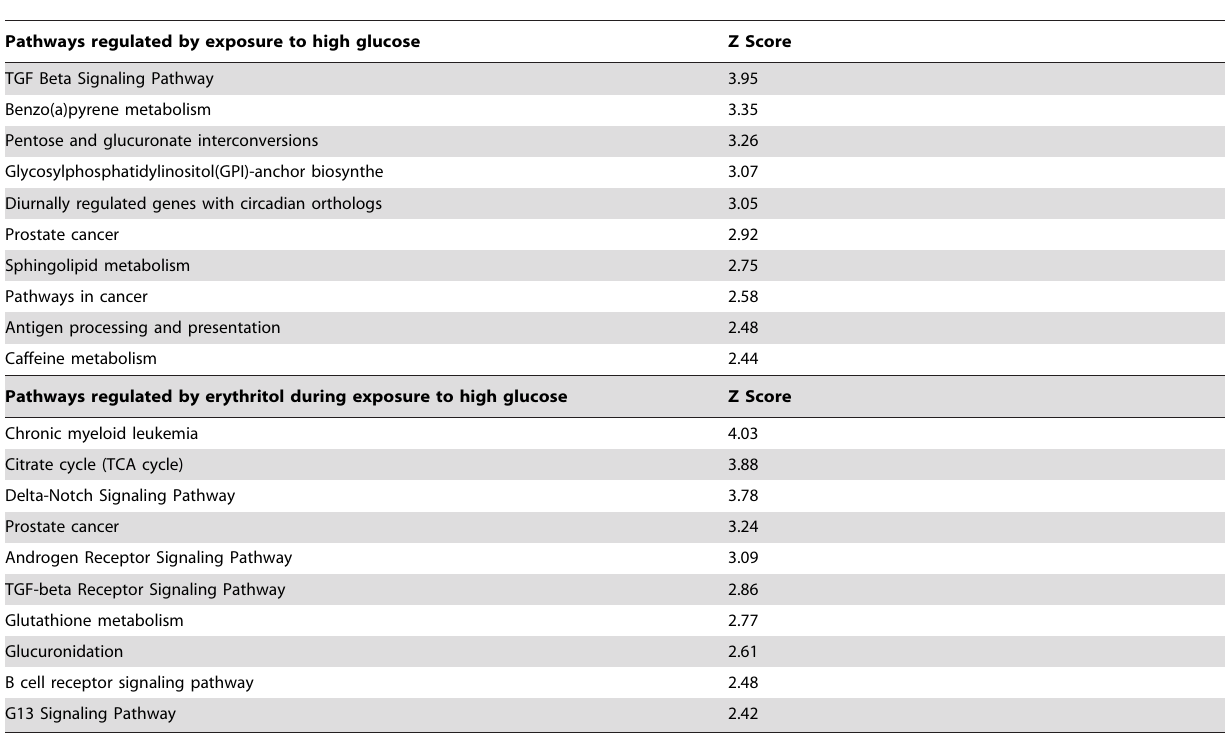
Table 3. Top 10 pathways regulated by exposure of HUVECs to high glucose (HG effect) or to erythritol during exposure to high glucose (HGERT